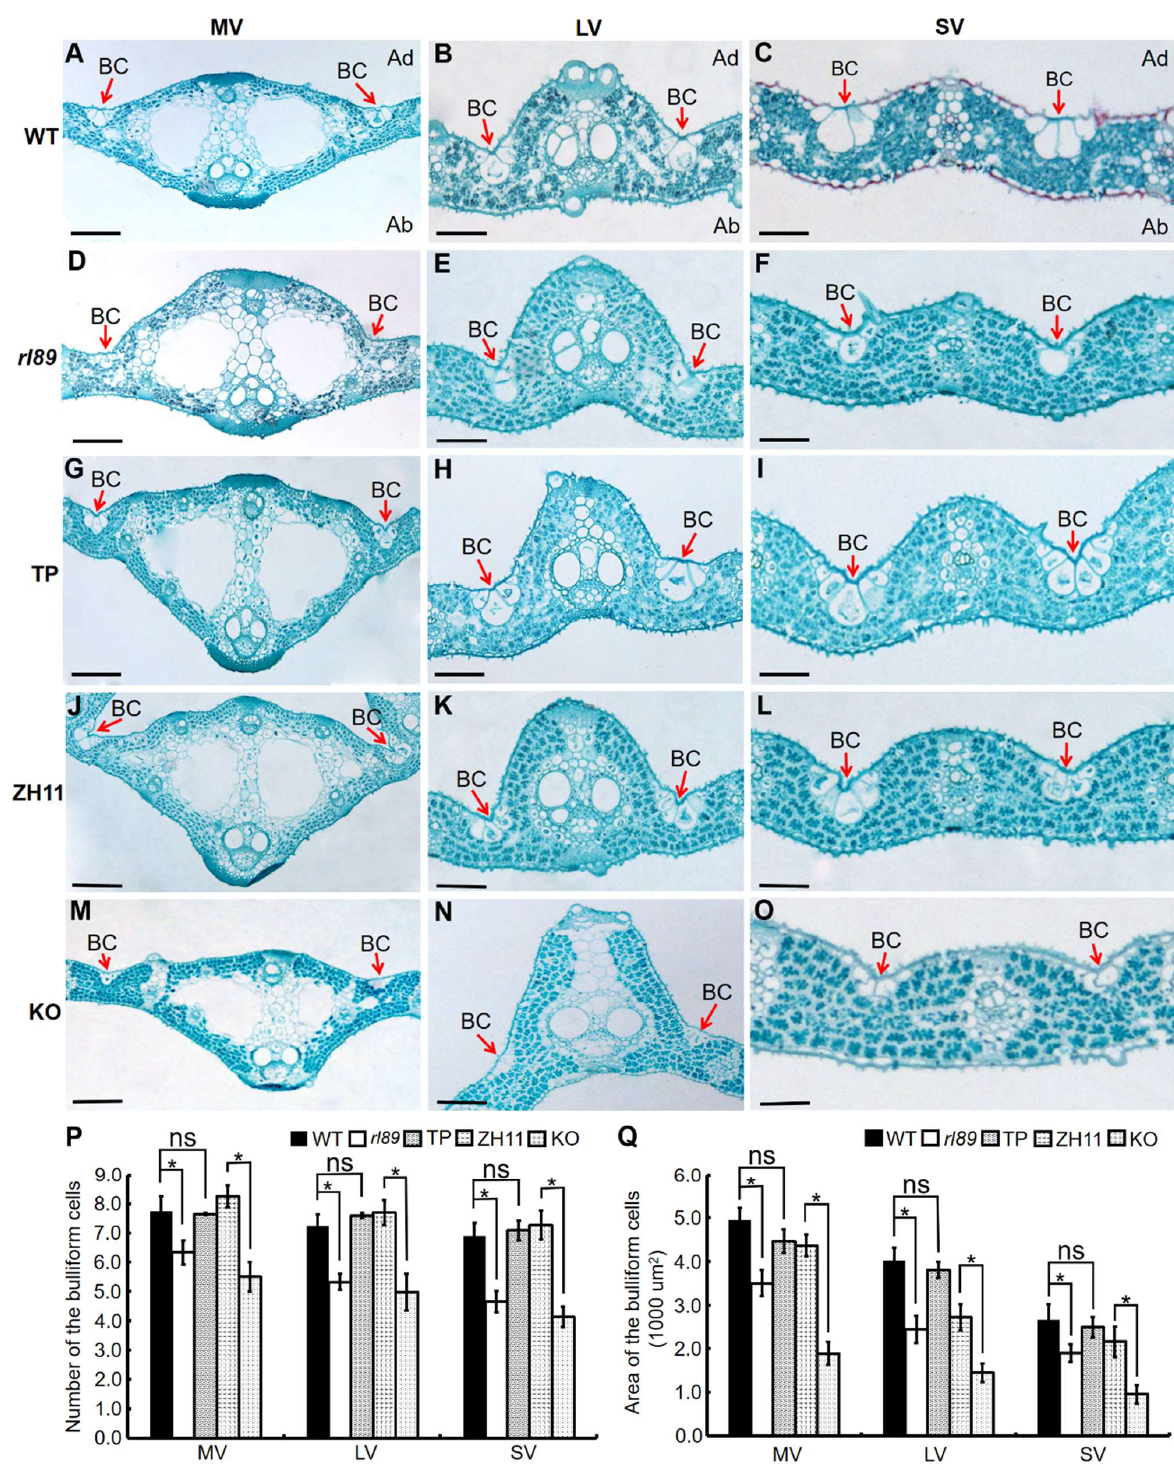
Figure 2. Number, size, and area of bulliform cells in midrib, large veins, and small veins of flag leaves at the booting stage. Cross sections of the middle sections of flag leaves in the wild type (WT, A – C ), the rl89 mutant ( D – F ), the OsDRB2 transgenic plants (TP, G – I ), the control variety Zhonghua 11 (ZH11, J – L ), and the OsDRB2 knockout mutant (KO, M – O ). MV, midrib vein; LV, large vein; SV, small vein; Ad, adaxial; Ab, abaxial. Red arrows indicate bulliform cell (BC) . Black bars indicate 100 μm. ( P ) and ( Q ) Statistical analysis of bulliform cells. Error bar represents the SD ( n > 6). * and ns indicate statistically significant and non-significant differences, respectively, at p < 0.05.